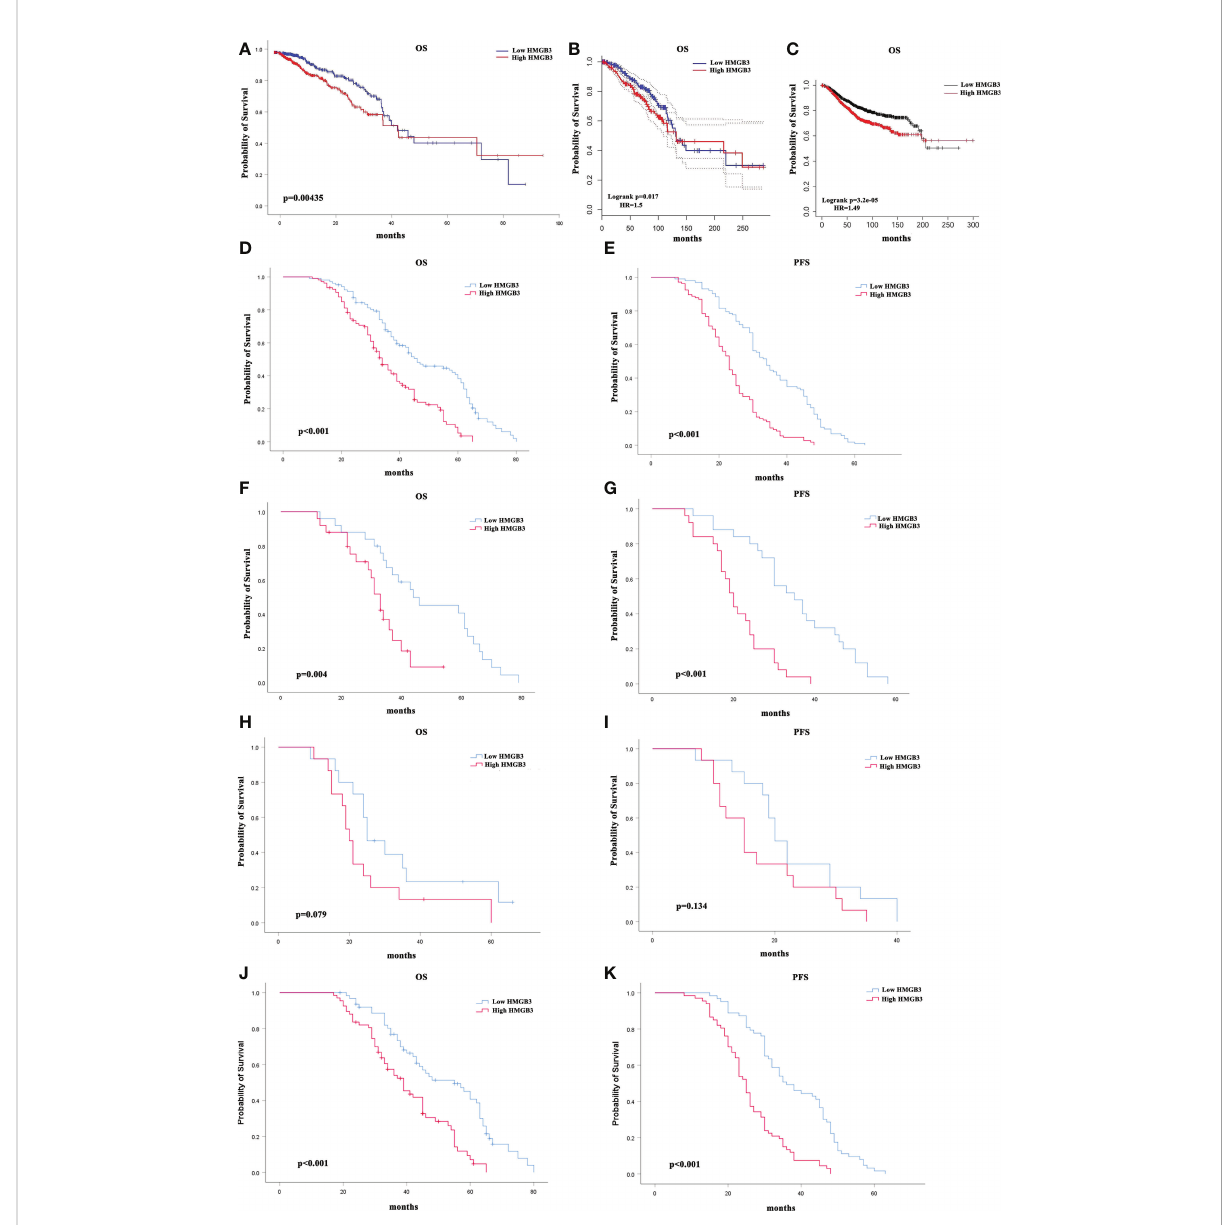
FIGURE 4 Correlation between breast cancer survival prognosis and HMGB3 gene expression. (A) With the OncoLnc web tool, the relationship between HMGB3 expression and breast cancer patient prognosis was analyzed. (B) The GEPIA database was used to analyze survival data. (C) HMGB3 survival analysis using Kaplan-Meier Plotter software. Survival analysis of a separate cohort of breast cancer patients treated in our center: Kaplan-Meier survival curves for OS (D) and Kaplan-Meier survival curves for PFS in breast cancer patients (E) . Kaplan-Meier survival curves for OS in subgroups of this cohort strati fi ed by HER2 positivity (F) , TNBC (H) , and ER positivity (J) in breast cancer patients. Kaplan-Meier survival curves for PFS in subgroups strati fi ed by HER2 positivity (G) , TNBC (I) , and ER positivity (K) in breast cancer